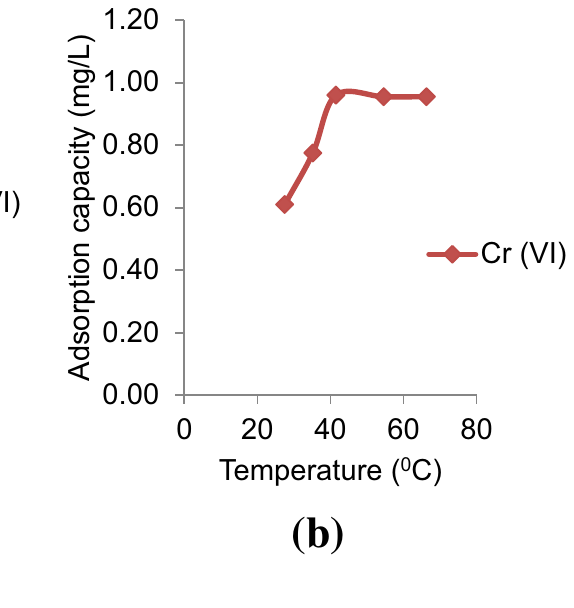
Fig. 6 Effect of temperature on the adsorption of Cr(VI)